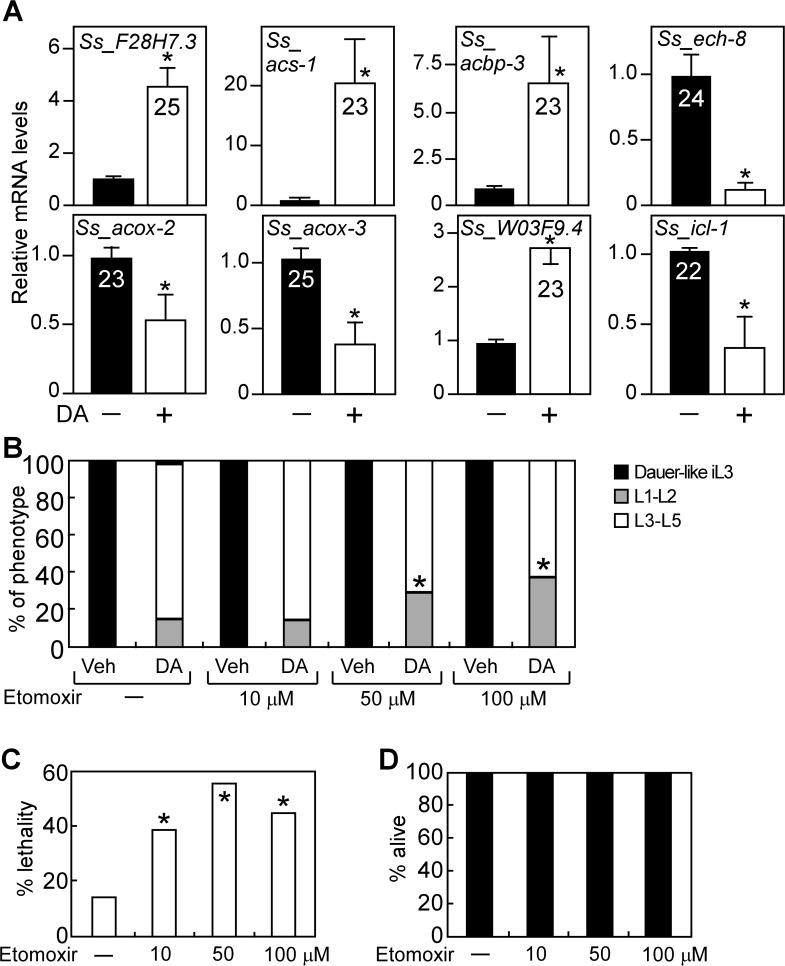
DAF-12-dependent regulation of lipid metabolism is conserved in S. stercoralis.(A) F28H7.3 (lipase), acs-1 (synthase), acbp-3 (transport), W03F9.4 (mitochondrial β-oxidation), ech-8, acox-2 and acox-3 (perioxisomal β-oxidation), and icl-1 (glyoxylate cycle) mRNAs were determined by qPCR from S. stercoralis iL3 larvae treated with or without 400 nM DA. Numbers in bars refer to Ct values. *P-value < 0.05 by Student’s t-test comparing DA to vehicle (n = 3 ± S.D.). (B, C) Effect of the mitochondrial fatty acid oxidation inhibitor, etomoxir, on reproductive development (B) and viability (C) in S. stercoralis post-free-living larvae treated with DA. *P < 0.05 by Fisher’s exact test comparing larvae treated with 300 nM DA ± etomoxir at the indicated concentrations (n = 3). (D) Etomoxir treatment does not cause lethality in developmentally arrested S. stercoralis iL3 larvae (n = 3). Vehicle, ethanol; DA, Δ7-dafachronic acid.